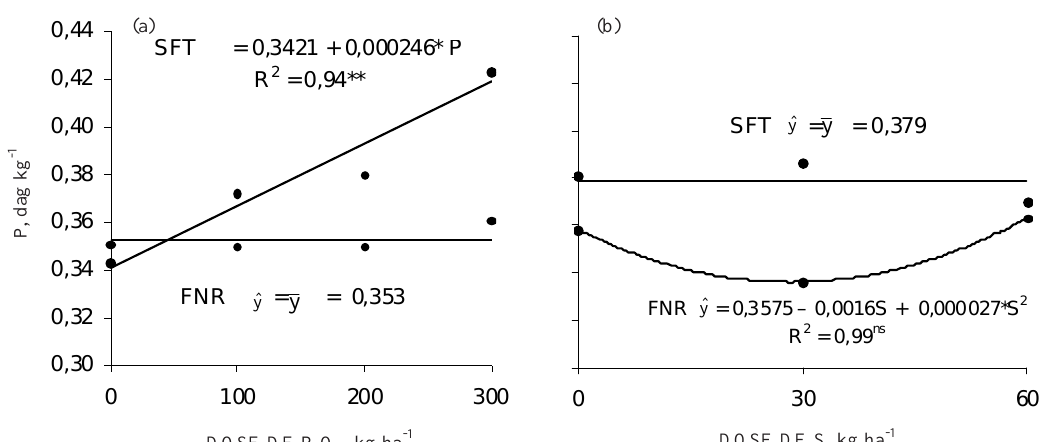
Figura 2. Teores de fósforo no tecido foliar, de acordo com as doses de fósforo (a) e de enxofre (b) para as fontes de superfosfato triplo e fosfato natural reativo.